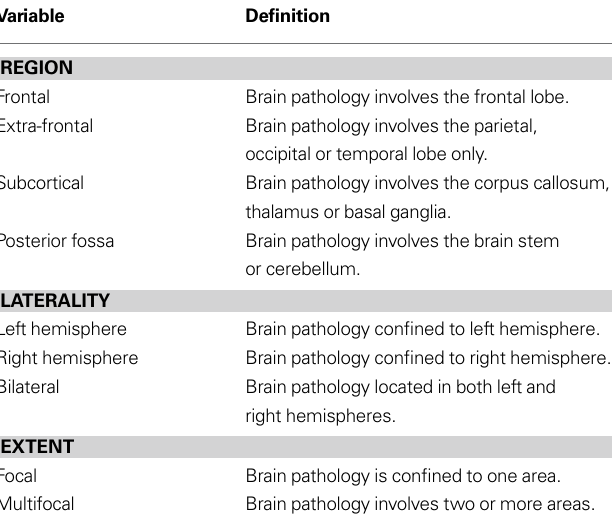
Table 2 | Defi nitions for classifi cation of lesion location, laterality and extent, based on MRI scan (adapted from Leventer et al., 1999).